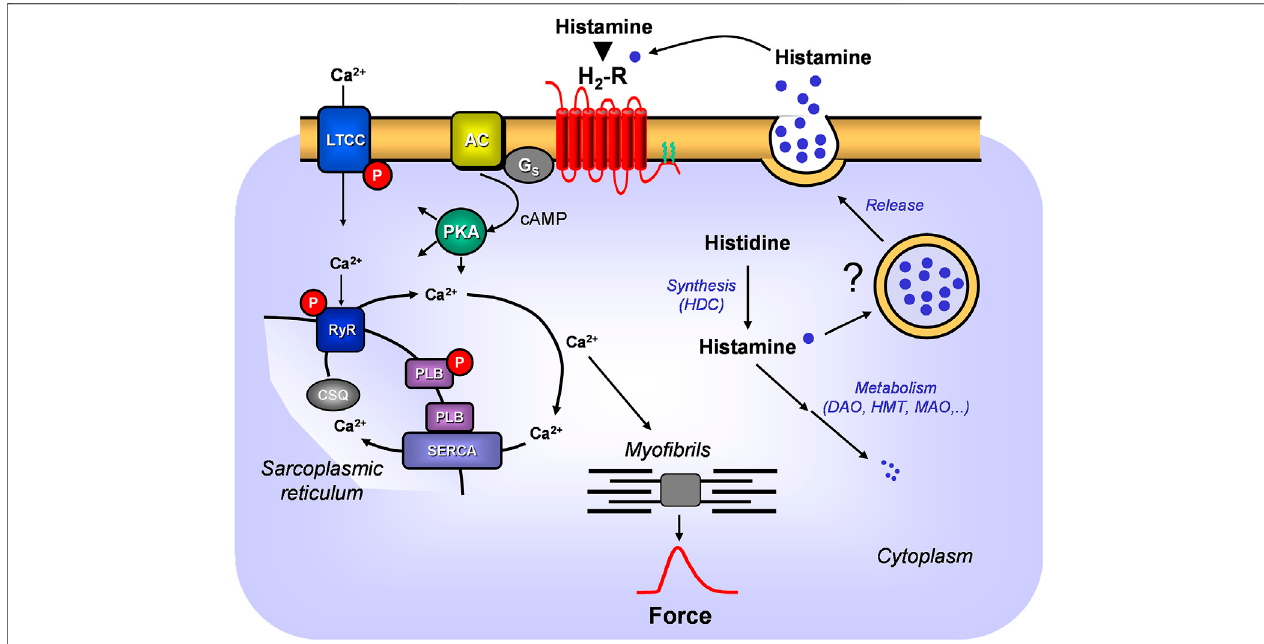
FIGURE 1 | A scheme of the putative signal transduction of the H 2 -receptor in the mammalian heart. Ca 2+ enters the mammalian heart cell via the L-type Ca 2+ channel (LTCC). This process can be enhanced by histamine and blocked by cimetidine via a cascade starting with the H 2 -receptor. Binding of histamine elevates the activity of adenylyl cyclase (AC) in the sarcolemma via stimulatory G-proteins (Gs), augmenting thereafter the cellular cAMP and thereby stimulates the activity of cAMP- dependent protein kinase (PKA). PKA increases cardiac force generation and relaxation by increasing the phosphorylation state (P) of LTCC, phospholamban (PLB), and other regulatory proteins. Trigger Ca 2+ initiates release of Ca 2+ from the sarcoplasmic reticulum via ryanodine receptors (RYR) into the cytosol, where Ca 2+ activates myo fi laments and leads to increased inotropy. In diastole, Ca 2+ is taken up into the sarcoplasmic reticulum (SR) via a sarcoplasmic reticulum Ca 2+ ATPase (SERCA)whoseactivity ishigher whenthephosphorylationstateofPLBiselevated byPKA. Ca 2+ bindstocalsequestrin(CSQ)intheSR.Moreover,theschemedepicts putative synthesis and degradation of histamine. More details are presented in Figure 2 . Further, the putative storage and release of histamine is indicated.